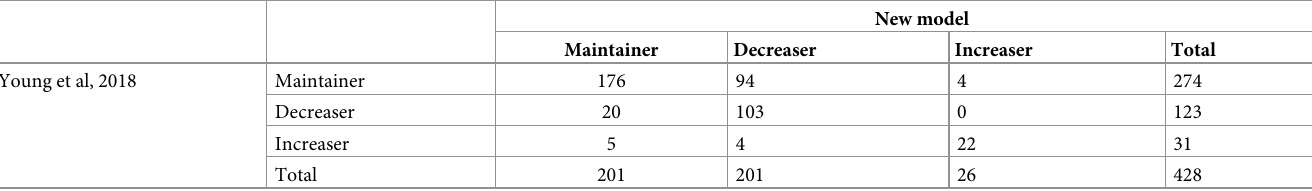
Table 3. Comparison of the clustering results with the previous